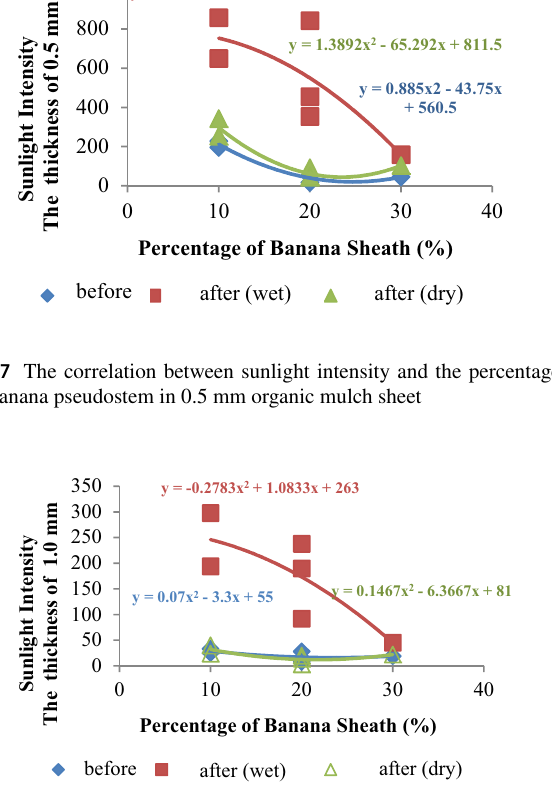
Fig. 5 The correlation between sunlight intensity and the percentage of rice straw in 0.5 mm organic mulch sheet